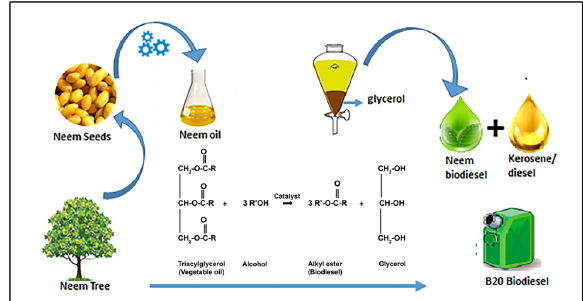
Fig. 1. Scheme for the synthesis of biodiesel from Neem